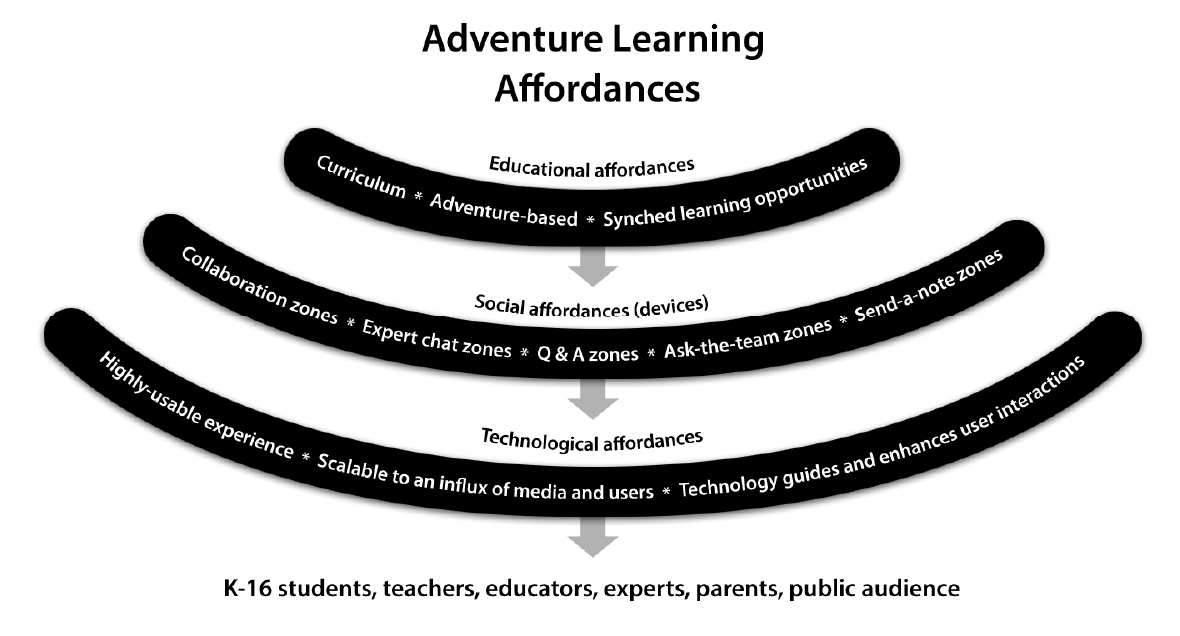
Figure 2 . Adventure learning affordances (Doering, Miller, & Veletsianos,